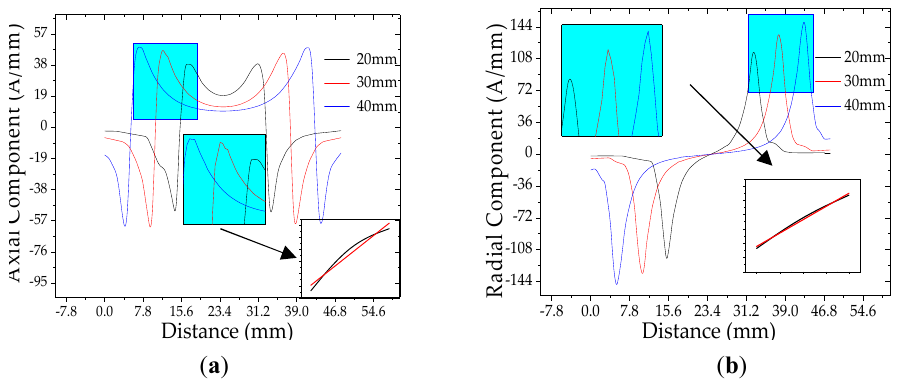
Figure 11. The weak magnetic signal of pipeline crack with different crack lengths: ( a ) axial component and ( b ) radial component. And the axial maximum and the radial peak of the weak magnetic signal at the crack are extracted, and the relationship between the signal and the crack length is shown in the figure.